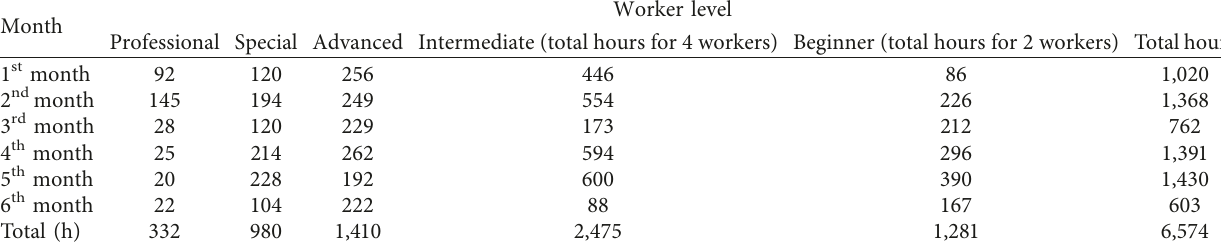
Table 4: Input manpower for digital fabrication